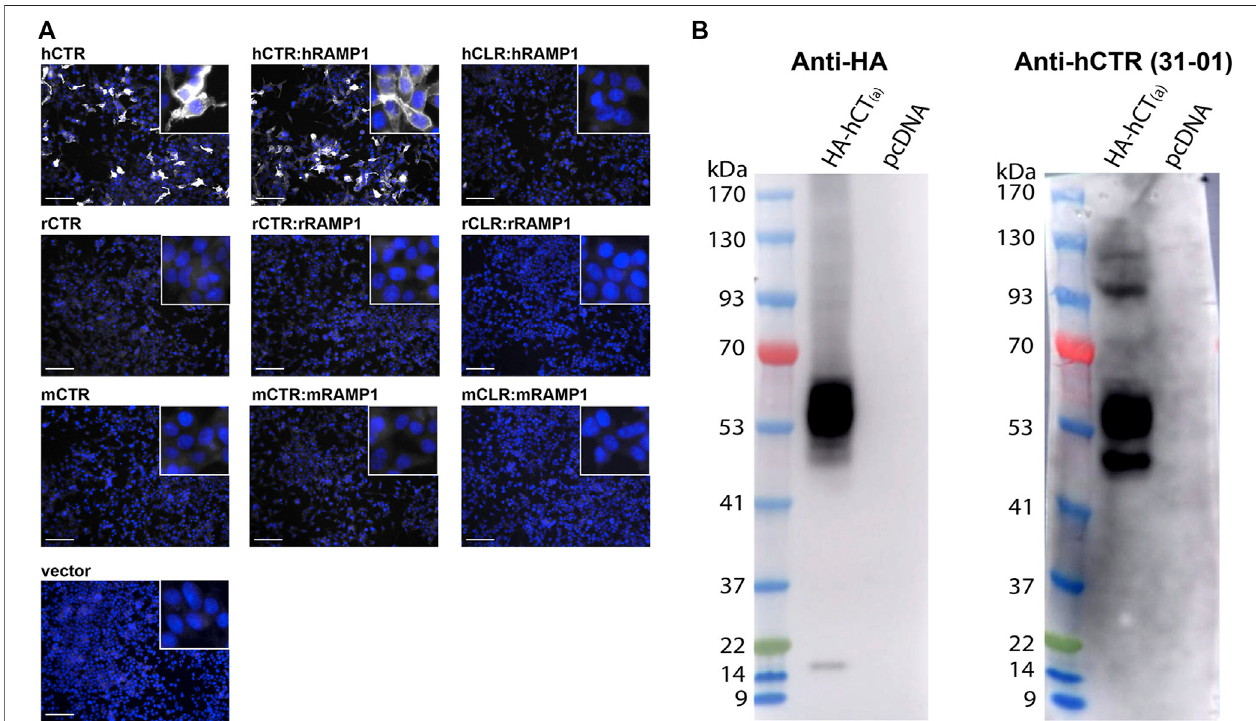
FIGURE 7 | Validation of the anti-human CTR mAb31-01 antibody in transfected HEK293S cells. (A) Immunocytochemistry, with immunoreactive staining in greyscale, and nuclear DAPI staining in blue. Scale bar = 100 μ m h, human; r, rat; m, mouse. Images are representative of three independent experiments in duplicate wells. (B) Immunoblots using cell lysate (10 µg) preparations from HEK293S cells transfected with HA-tagged human CTR or vector alone (pcDNA). Lanes were loaded with 10 μ g of protein. Blots were probed with anti-HA (1 µg/ml) or mAb31-01 (2 µg/ml). MW markers are shown on the left of each blot, with apparent MW in kDa. This image is representative of four technical replicates using the same lysate preparations. The brightness and contrast of these images have been enhanced uniformly for presentation purposes.